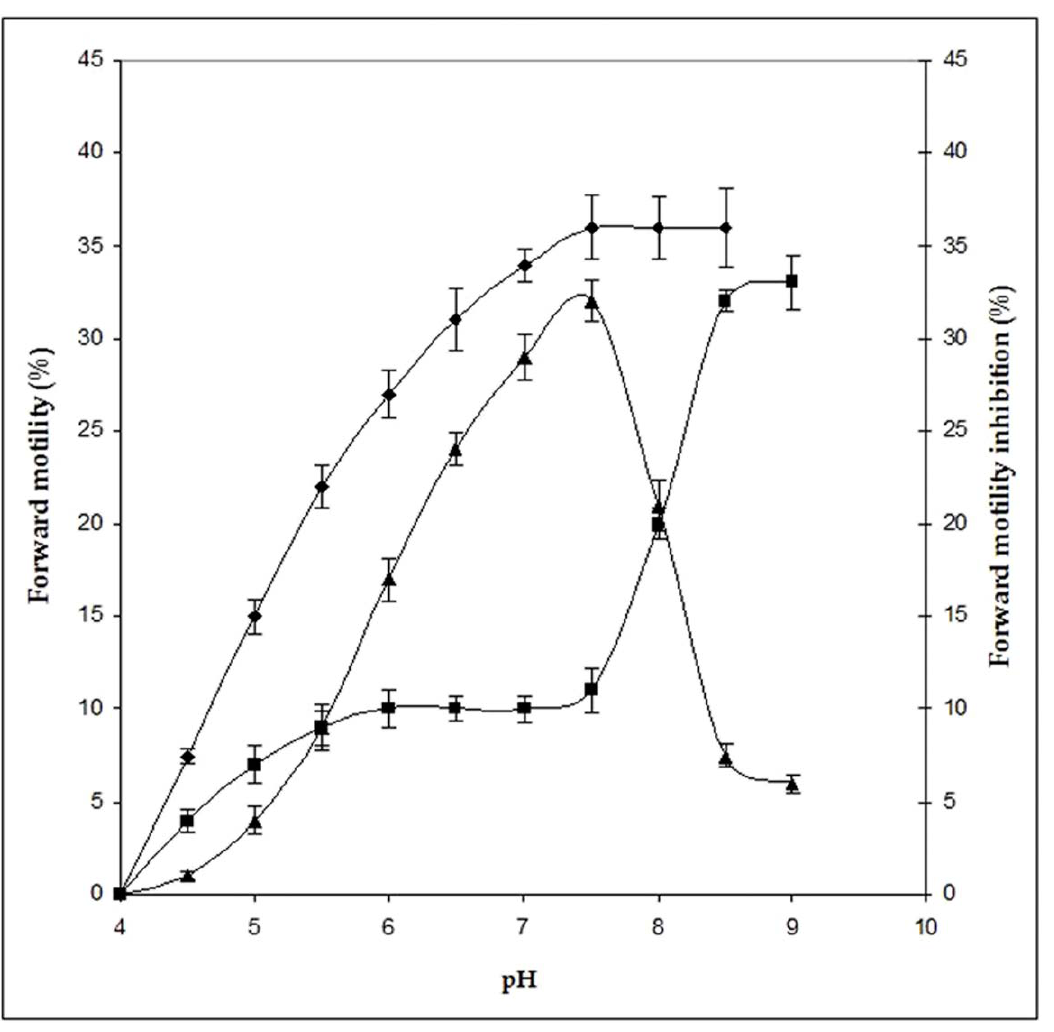
Figure 6. Effect of pH on the activity of MIF-II. Standard assay conditions were used except for the variation in pH of the RPS medium. Amount of MIF-II used was 2 m g/ml each. The data shown are mean 6 SEM of three experiments. ( ¤ ): Control; ( & ): MIF-II treated (% FM); ( m ): MIF-II treated (% FM inhibition).